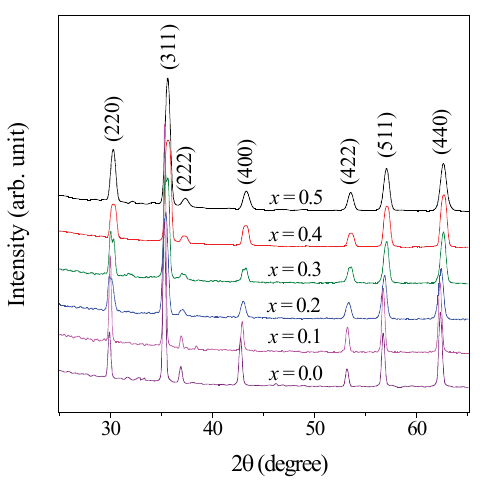
Figure 1. XRD patterns of CoAl Table 1. Lattice constant (a), X -ray density (d